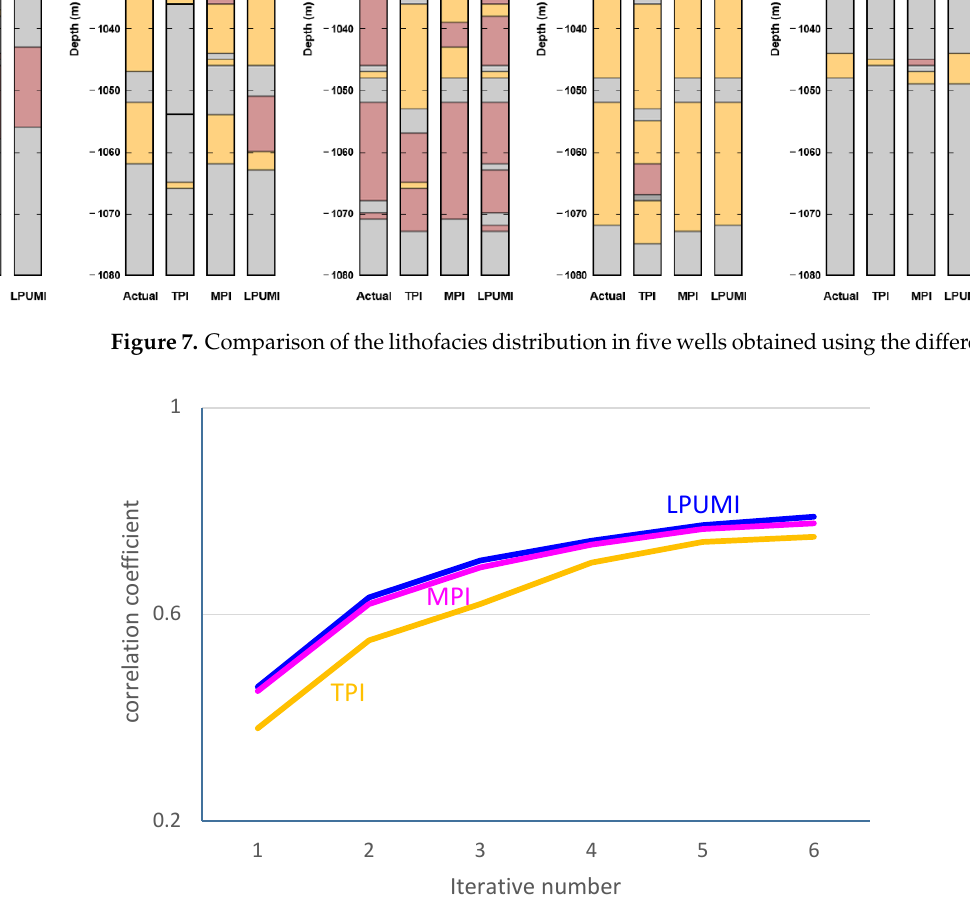
Figure 8. Correlation coefficients between the inversion trace and actual trace.